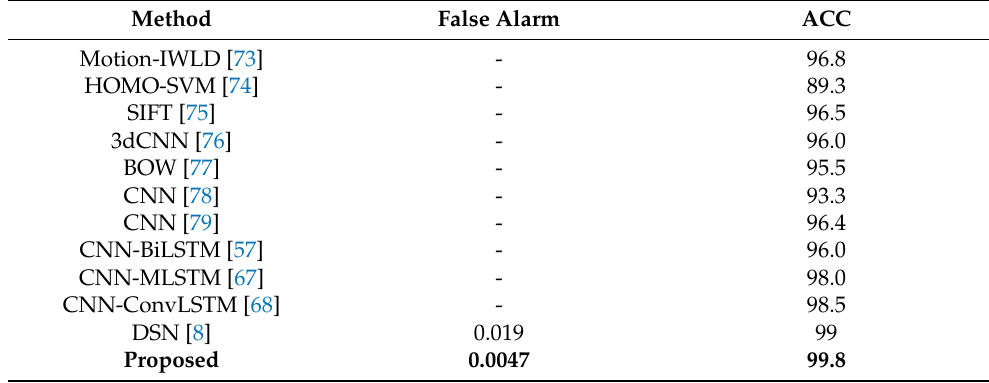
Table 4. Performance comparison of the proposed model with other SOTA over Hockey Fight dataset. Method